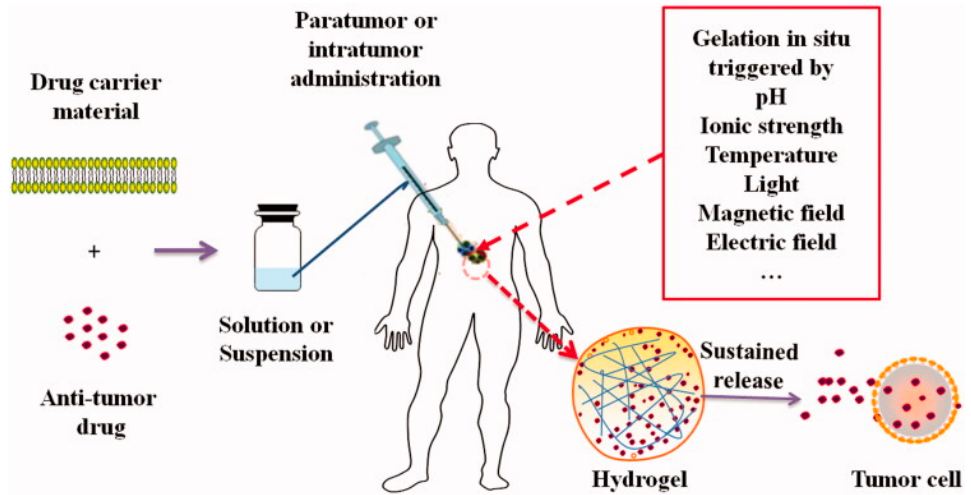
Figure 6. Schematic process of formation of in situ hydrogel and sustained release of drugs from the hydrogel into tumor cells. Adapted with permission from [120]. Copyright 2022, Taylor & Francis.